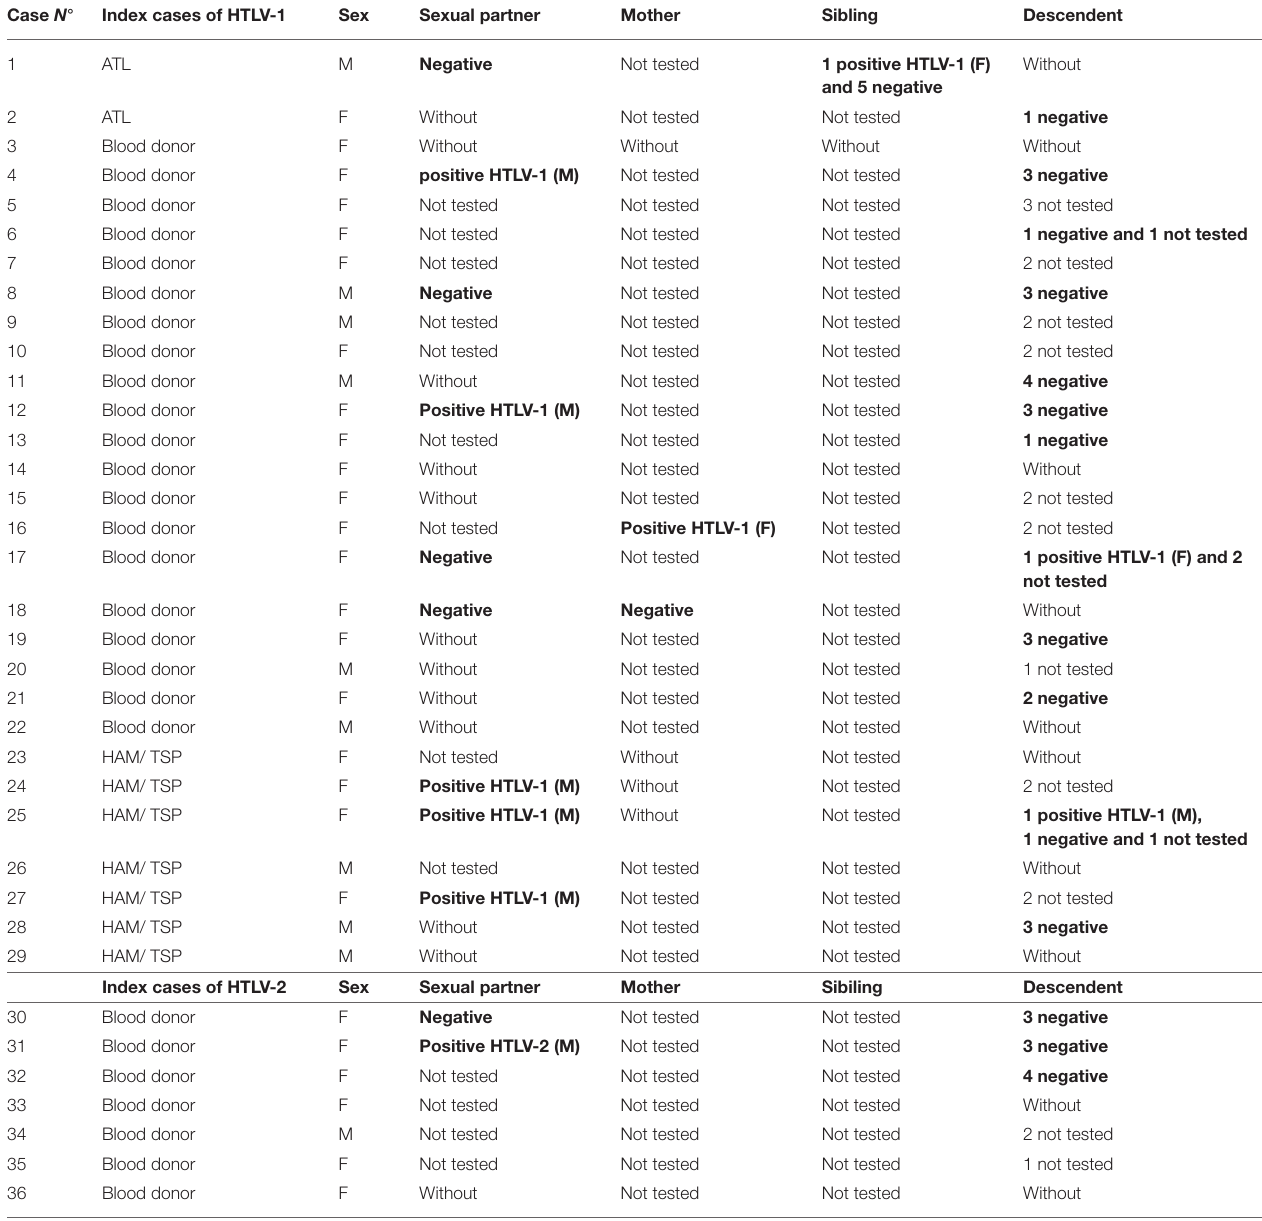
TABLE 1 | Relationship between index cases of human T-cell lymphotropic virus (HTLV)-1 and − 2 and family members. Case N